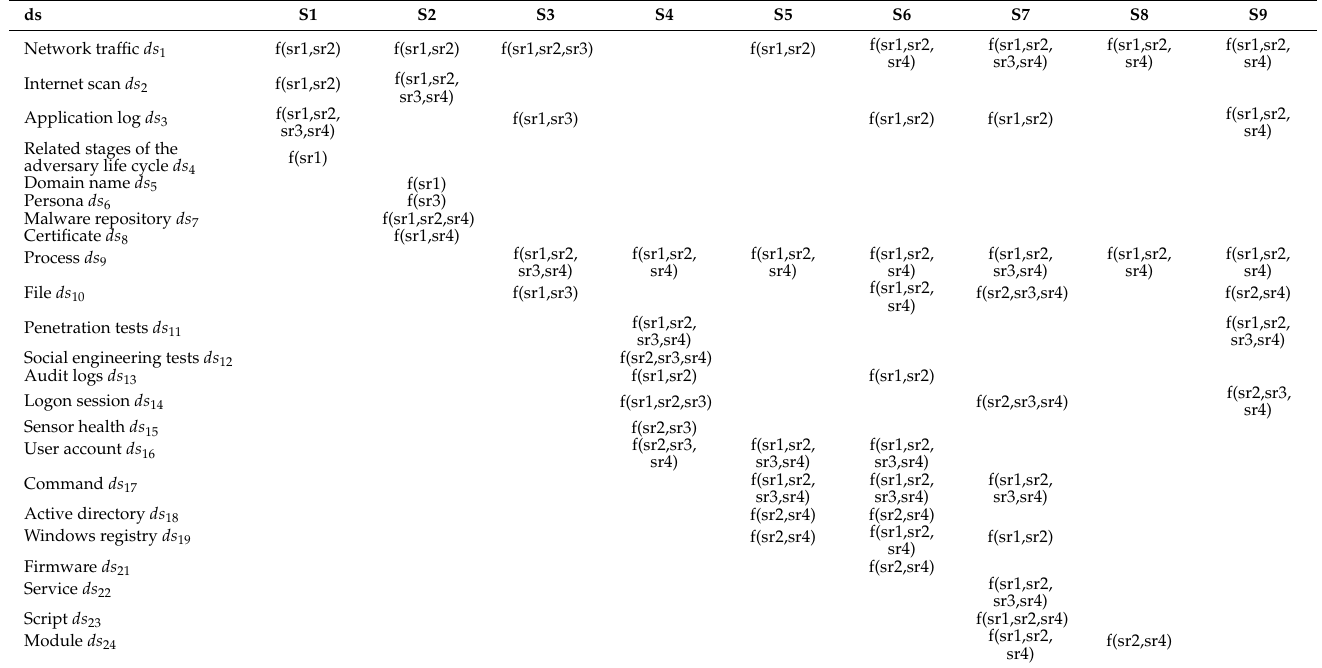
Table 6. Synthesis of TechSec and OpSec in data sources at different stages of